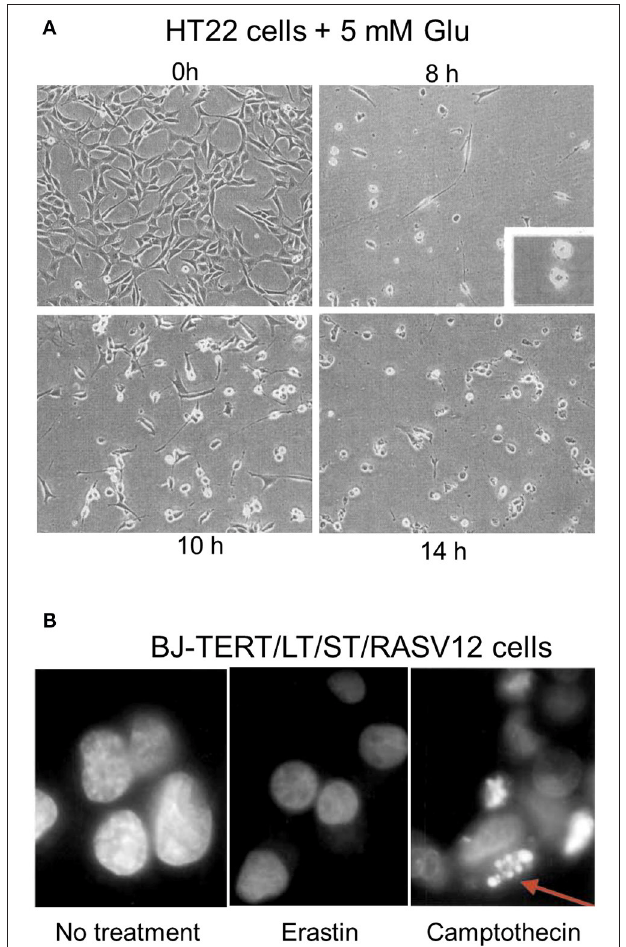
FIGURE 2 | Light microscopic changes of cellular shape during oxytosis and the nucleus during ferroptosis. (A) HT22 cells exposed for indicated durations to 5mM glutamate and observed by phase contrast microscopy. Cells were untreated (left upper) or treated with 5mM glutamate for 8h (right upper), 10h (left lower), or 14h (right lower) before examination under a phase-contrast microscope. Inset in the right upper shows blebs on surface of cells. (B) Lack of prominent nuclear changes in erastin-treated BJ-TERT/LT/ST/RASV12 cells while camptothecin-treated cells display fragmented nuclei (arrow). [Modified and reproduced with permission from (A) (Tan et al., 1998b) and (B) (Dolma et al.,